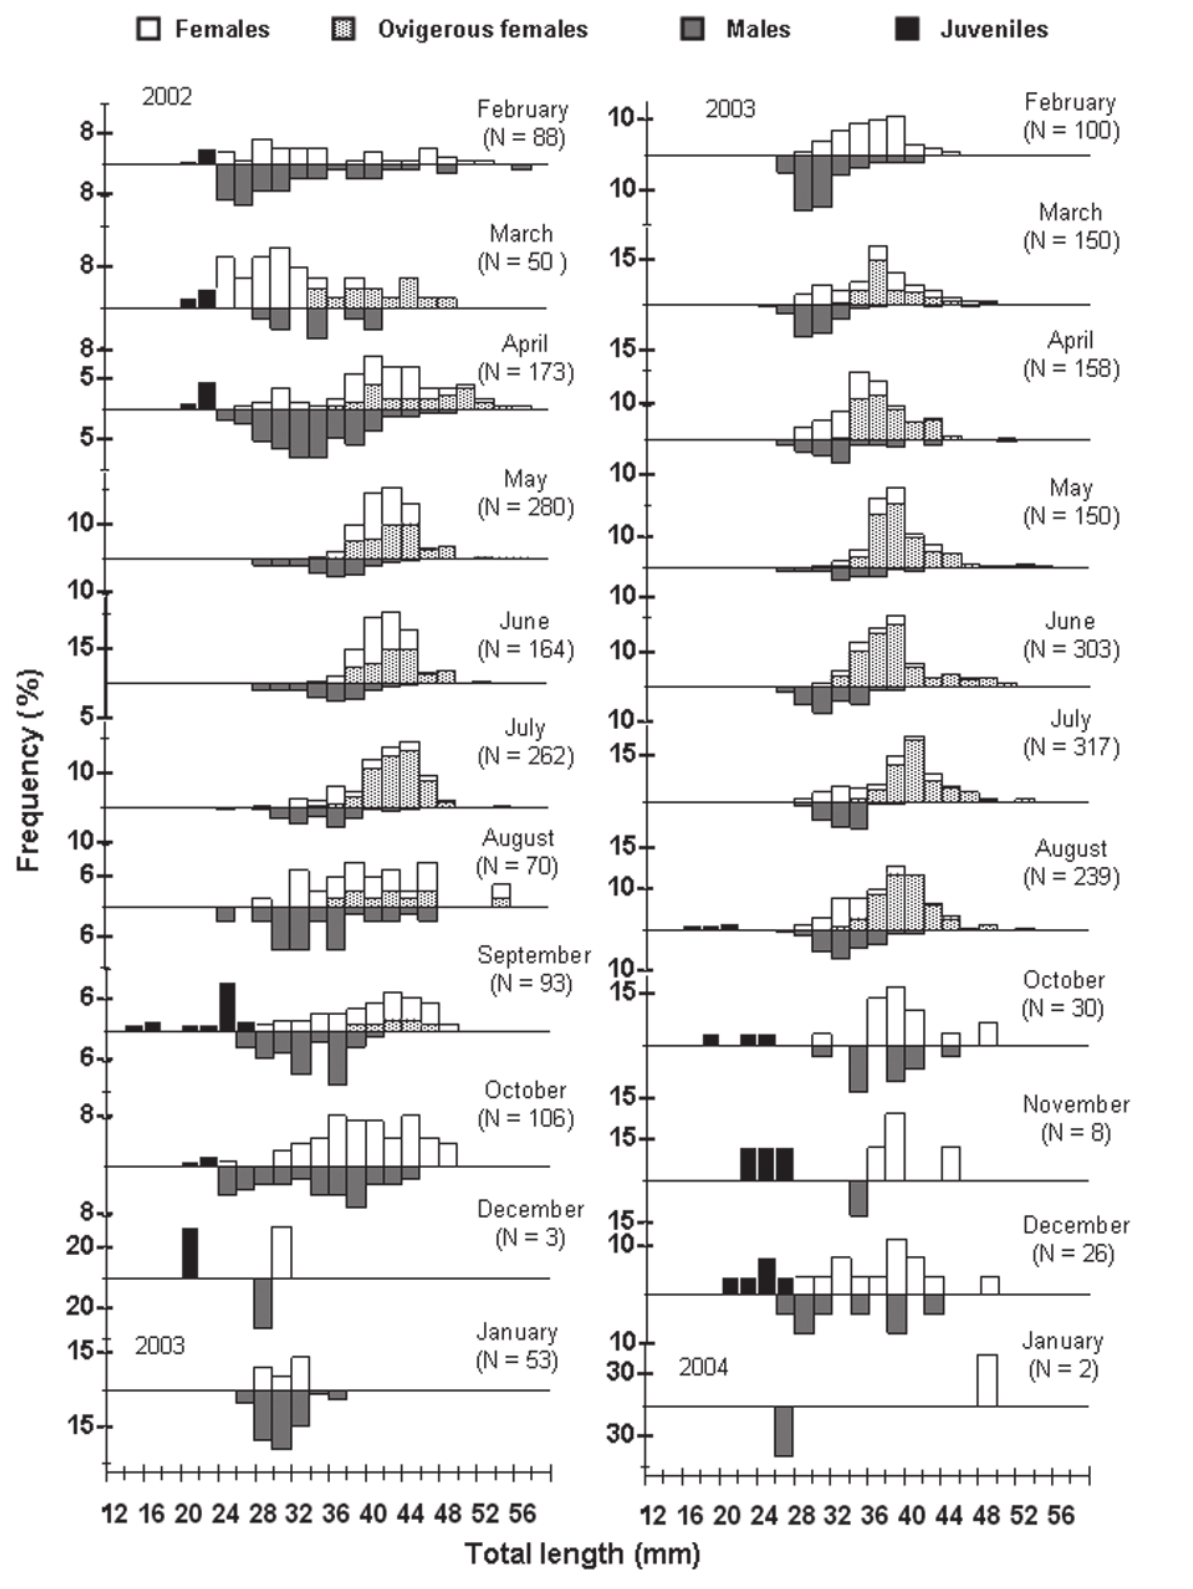
Fig . 2. – monthly length (2 mm size classes) frequency distributions (in percentages) of females, ovigerous females, males, and juveniles of Palaemon elegans between February 2002 and January